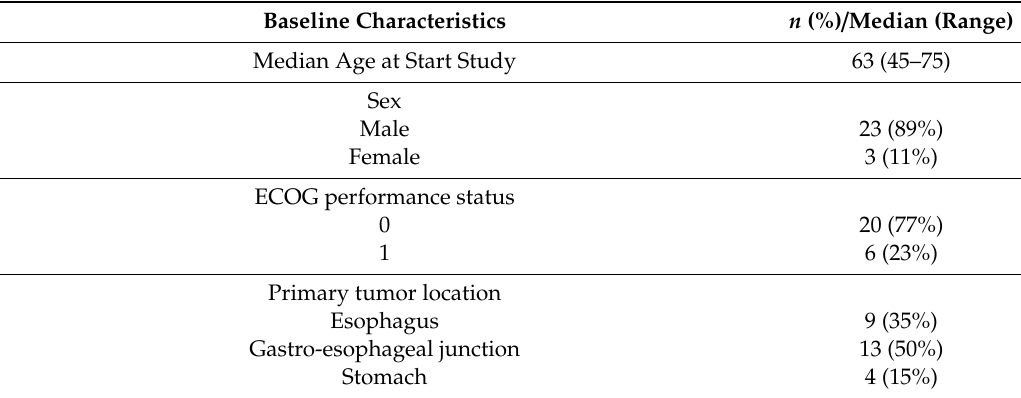
Figure 2. Dose escalation and dose limiting toxicity. Flow diagram of the number of patients per dose level, and the choice for subsequent dose levels based on the occurrence of DLTs and toxicity. DLT: dose-limiting toxicity; MTD: maximum tolerated dose; RP2D: recommended phase II dose. Table 1. Baseline